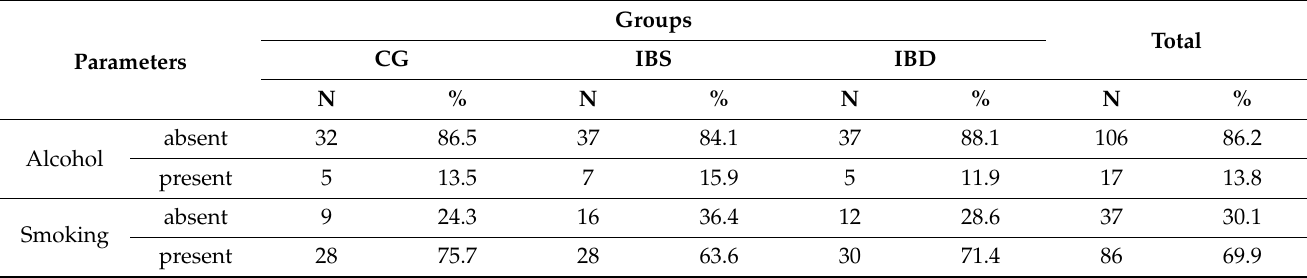
Table 6. Description of risk factors in the three